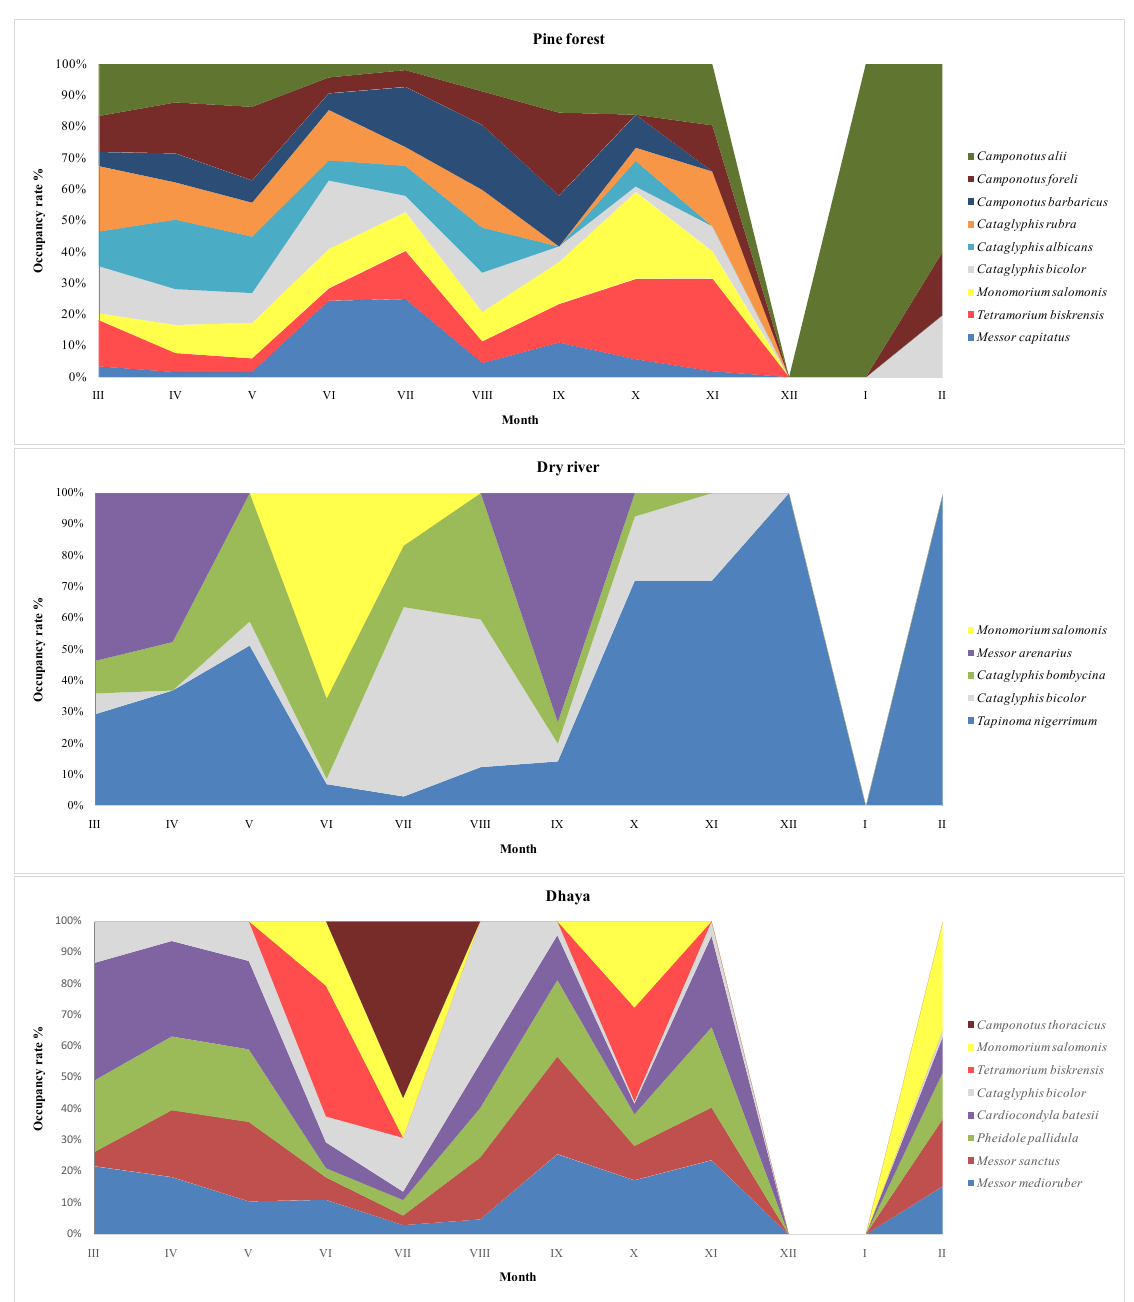
Fig 4. Seasonal variation in ant community trapped by pitfall in the three habitats